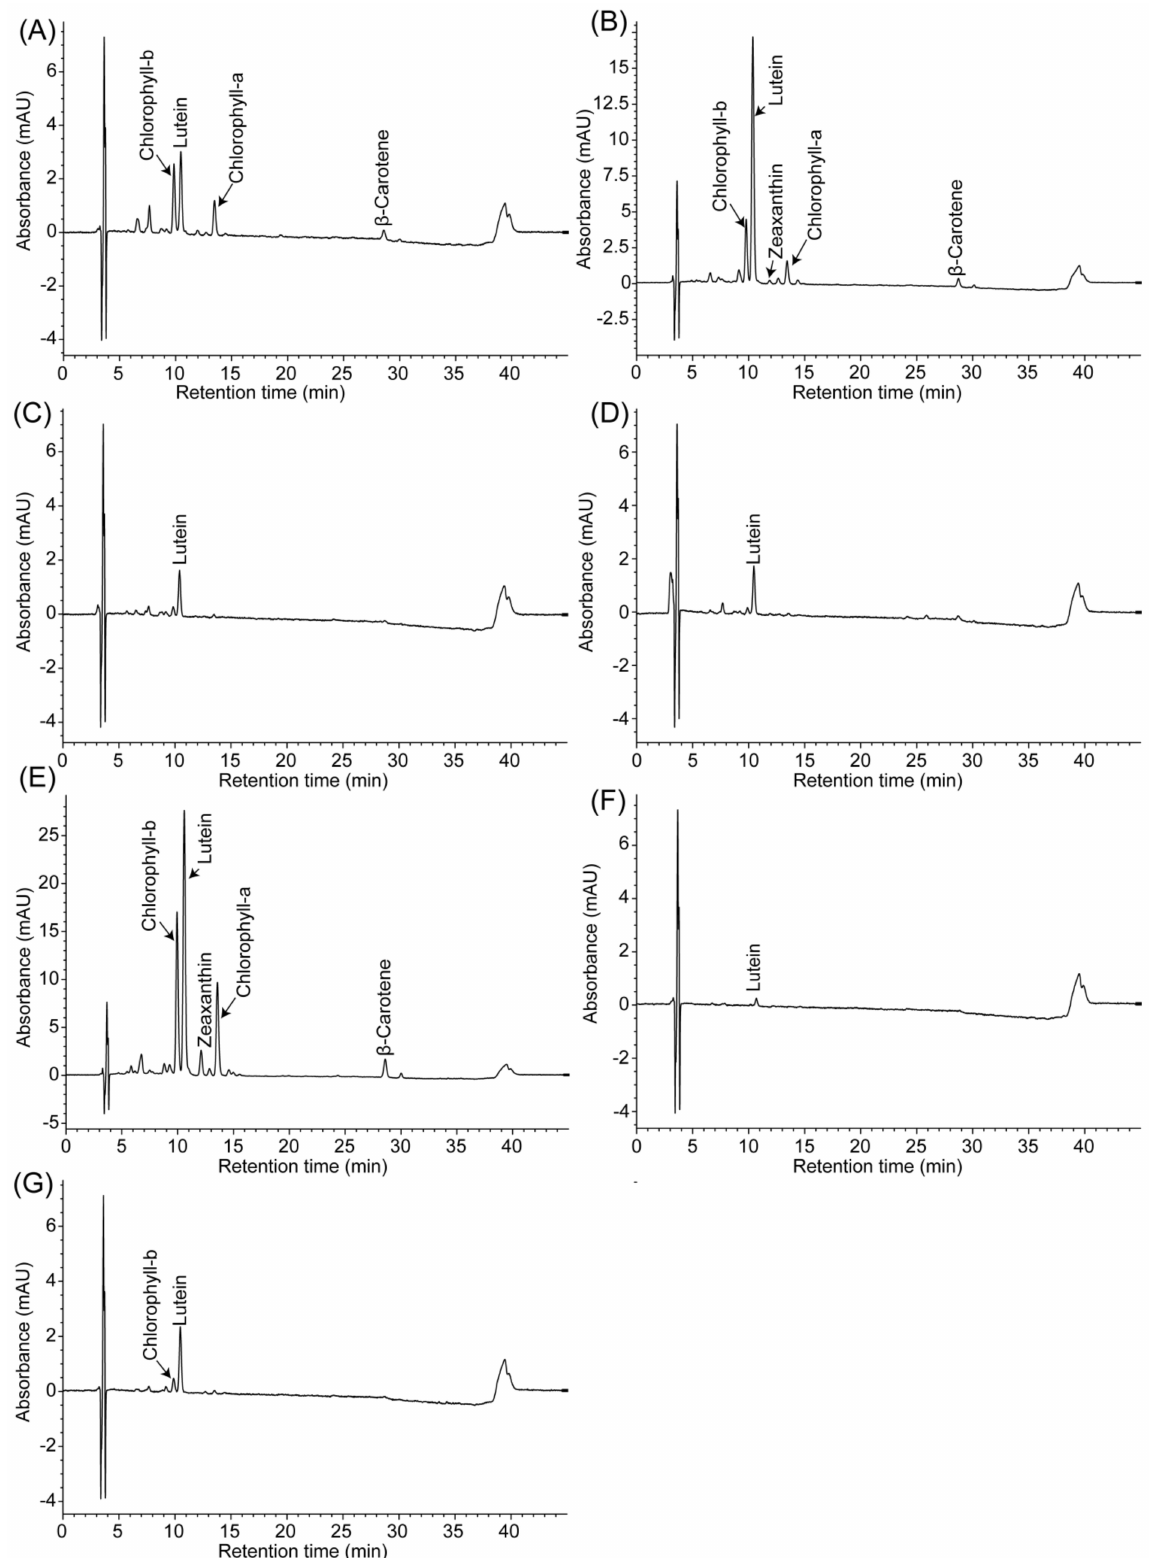
Figure 5. Chromatograms of different legumes. ( A ) Lablab ( Lablab purpureus) ; ( B ) Mungbean ( Vignia radiate) ; ( C ) Cowpea ( Vigna unguiculata) ; ( D ) Runnerbean ( Phaseolus multiflorus) ; ( E ) Pea ( Pisum sativum) ; ( F ) Adzuki bean ( Vigna angularis) ; ( G ) Fababean ( Vicia faba)